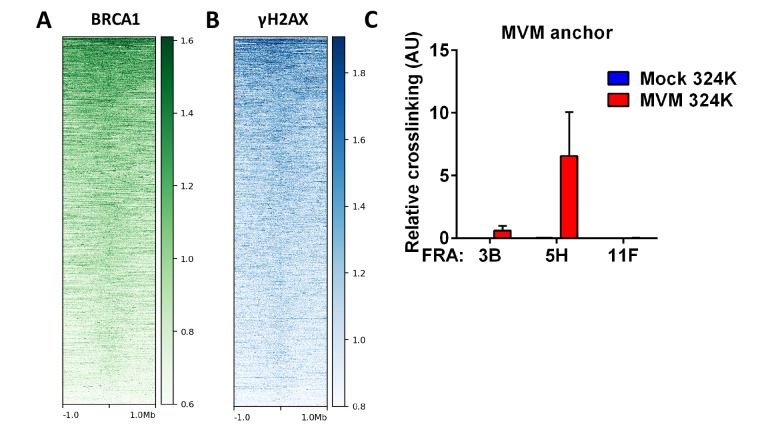
Called peaks from DDR ChIP-seq in HU-treated primary mouse splenocytes were compared with DDR ChIP-seq in MVM infected murine A9 fibroblasts at 16 hpi.The comparisons are presented in the form of heatmaps for (A) BRCA1 binding (green) and (B) γ-H2AX modification (blue). (C) The spatial interaction of MVM with common fragile sites were assayed in parasynchronized human NB-324K cells infected with MVM for 16 hr. Focused 3C-qPCR was performed with Taqman probes on the MVM genome, and assayed for interaction with the prototypical human fragile site FRA3B, as well as two other sites FRA5H and FRA11F. Data is presented as mean ± SEM of three independent experiments.